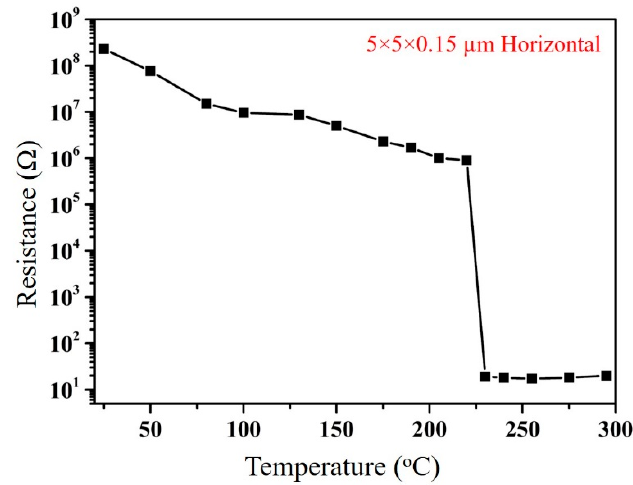
Figure 4. Temperature induced amorphous to crystalline phase transition in a horizontal GeTe resistor.